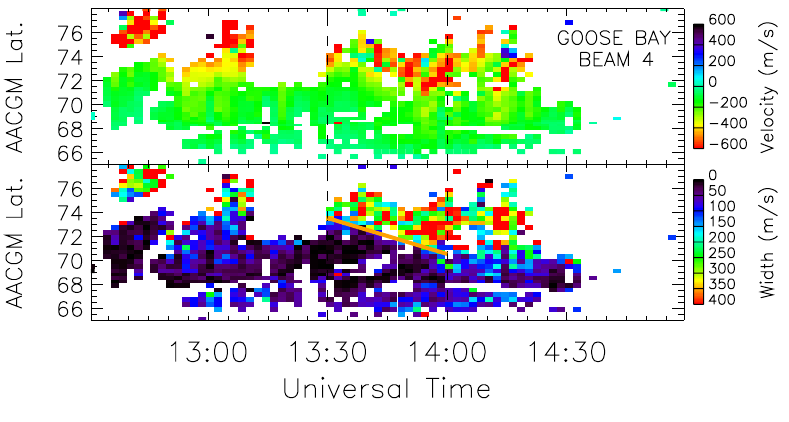
Fig. 4. The two panels show the line- of-sight Doppler velocity (upper panel) and the Doppler spectral width (lower panel) measured by the Goose Bay radar on beam 4 (aligned with the mag- netic meridian). The orange sloping line on the lower panel marks the equa- torward movement of the boundary be- tween high and low spectral